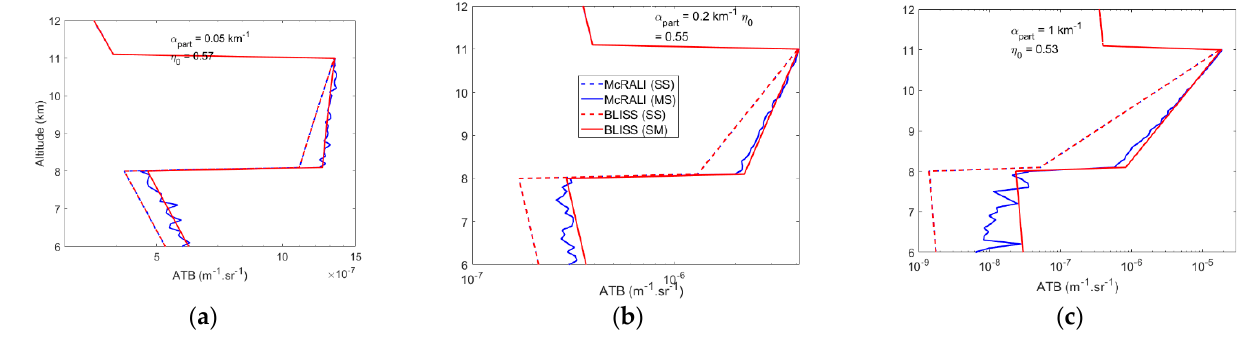
Figure 5. Vertical profiles of ATB computed by BLISS (red curves) and McRALI (blue curves) for cirrus clouds in single (dotted curves) and multiple (full curves) scattering regimes with R ef f = 28.4 µ m. Cirrus extinction α part and BLISS multiple-scattering coefficient η 0 are ( a ) 0.05 km − 1 and 0.57, ( b ) 0.2 km − 1 and 0.55 and, ( c ) 1 km − 1 and 0.53.